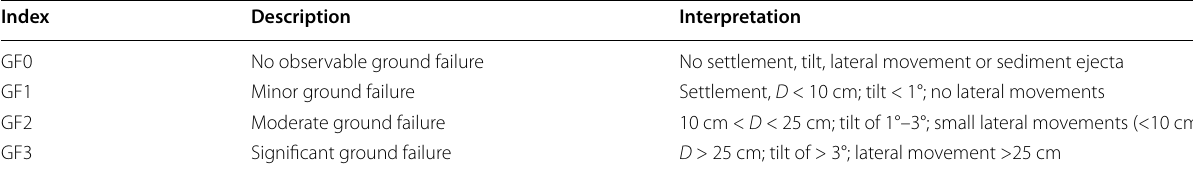
Table 1 Ground failure index (after Bray and Stewart